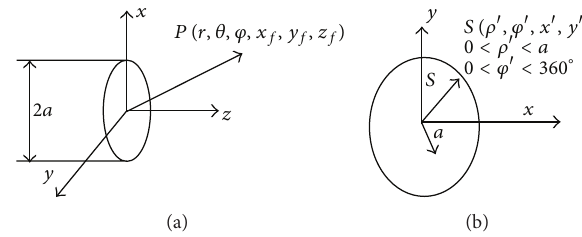
Figure 1: Coordinate system for near field analysis of circular